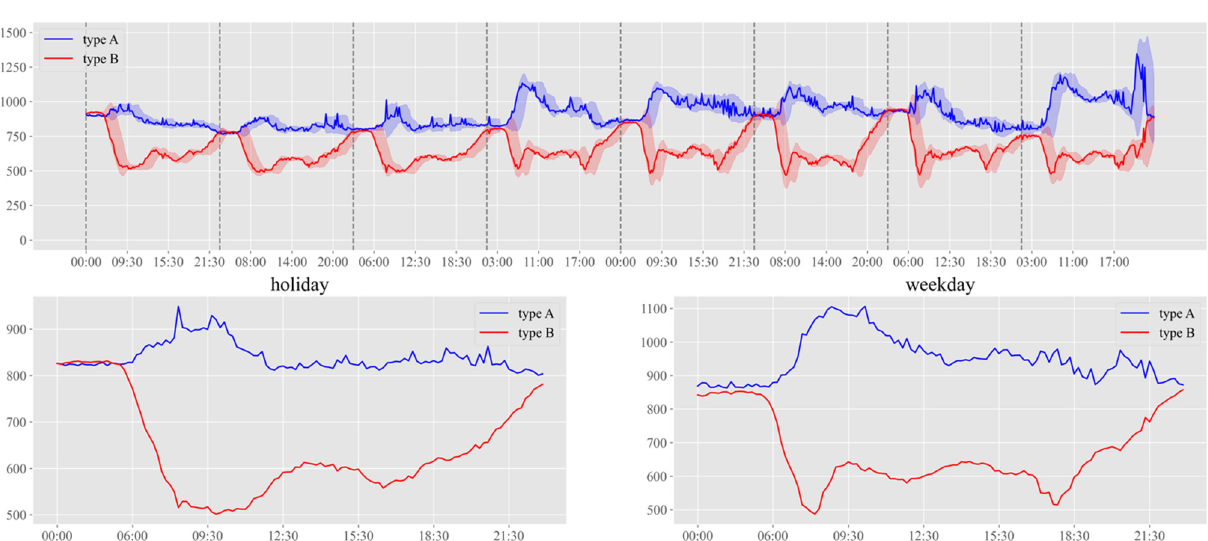
Figure 5. Statistical result of demand conflict. Red line, NAB higher than 0.74; blue line, NAB lower than 0.25.